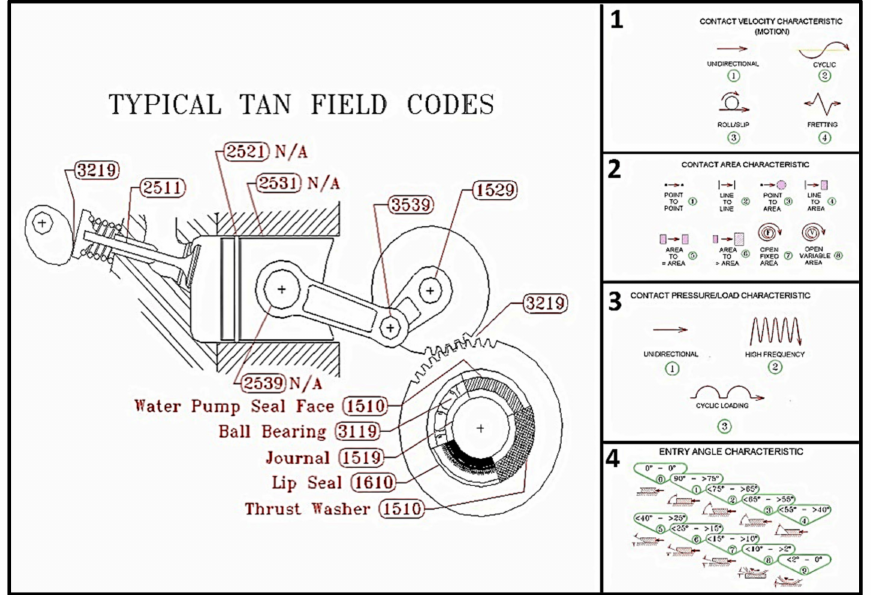
Figure 2. Schematic showing examples of TAN numbers and the four main criteria for number selection